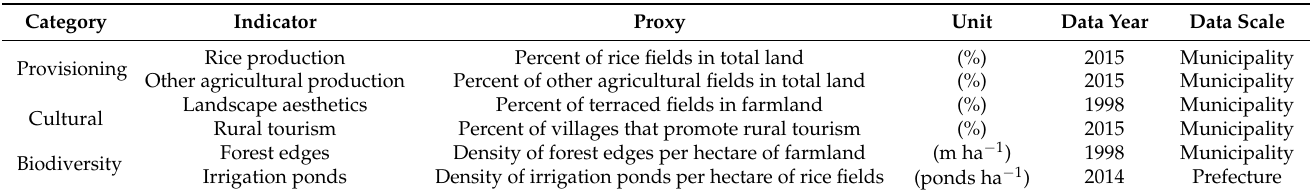
Table 1. List of agricultural ecosystem services and farmland biodiversity